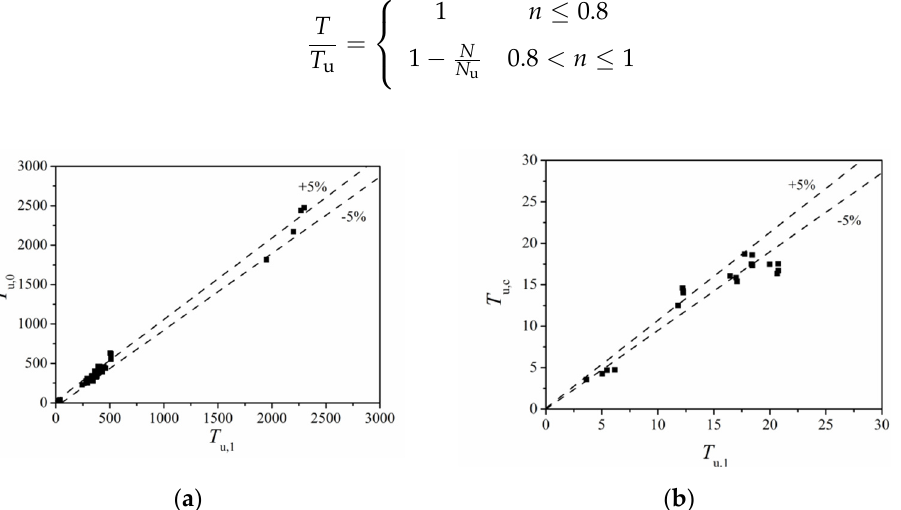
Figure 15. Calculation formula verification result: ( a ) FE values and formula values; ( b ) test and formula values.